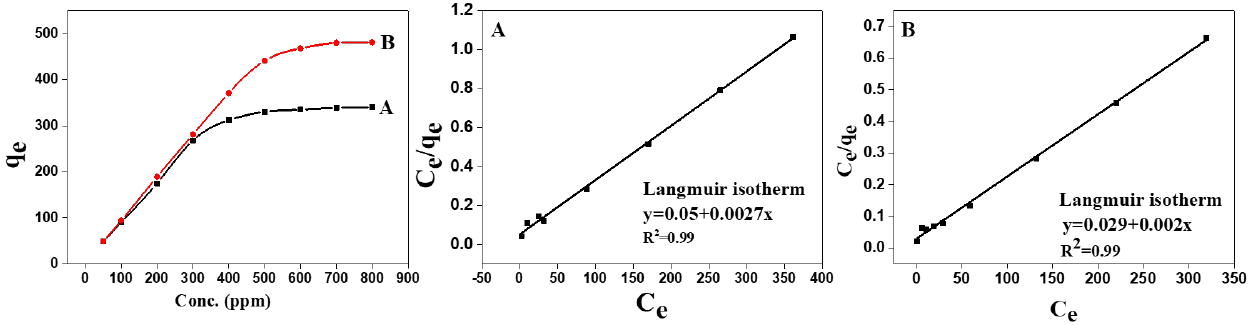
Figure 6. Effect of the initial MB concentration on adsorption capacity and Langmuir adsorption isotherm models for TOCNF1 ( A ) and TOCNF2 ( B ).